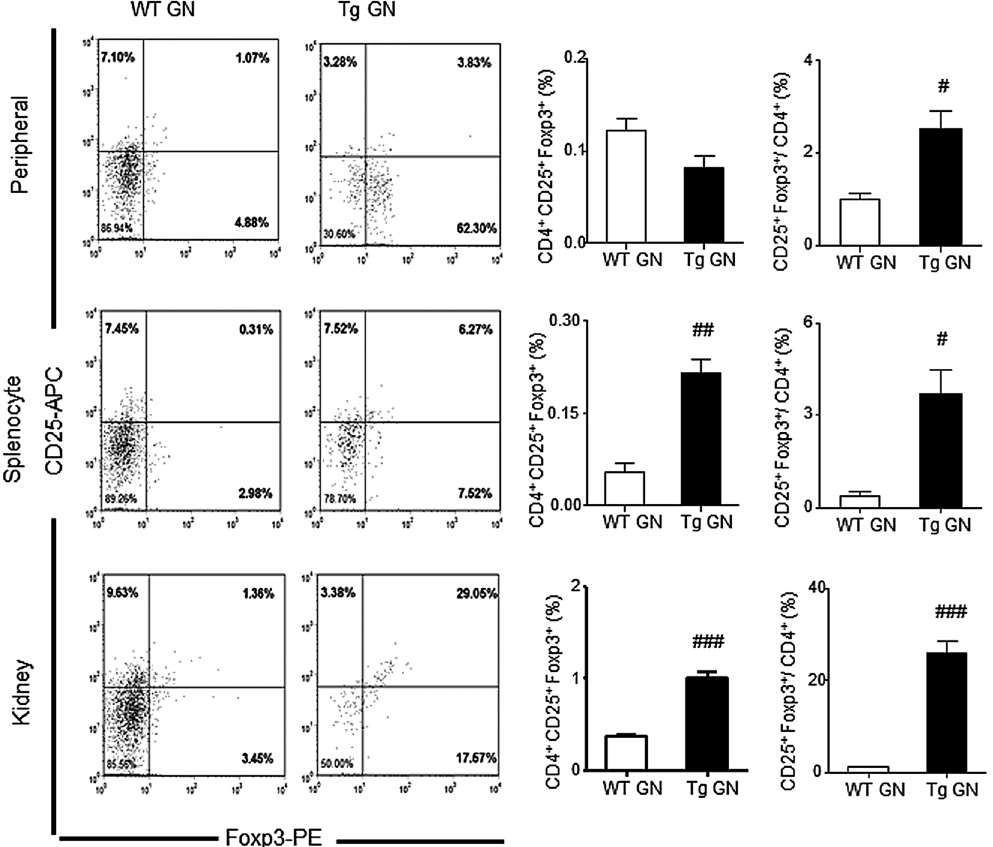
Figure 4. Overexpression of Foxp3 increases CD4 + CD25 + Foxp3 + regulatory T cells in anti-GBM GN. Flow cytometric analysis of peripheral and splenic and renal infiltrated CD4 + CD25 + Foxp3 + Tregs from diseased WT and Tg mice. Gated on CD4 + T cells. Each bar represents mean ± SEM. # p < 0.05, ## p < 0.01 and ### p < 0.001 compared with the WT mice. n = 3 mice per